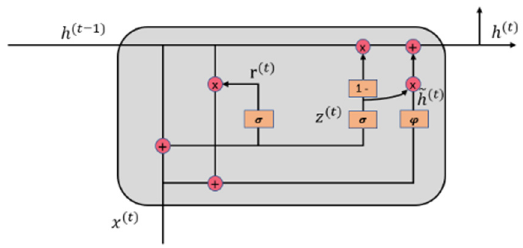
Figure 4. Illustration of gated recurrent units (modified from [22]).